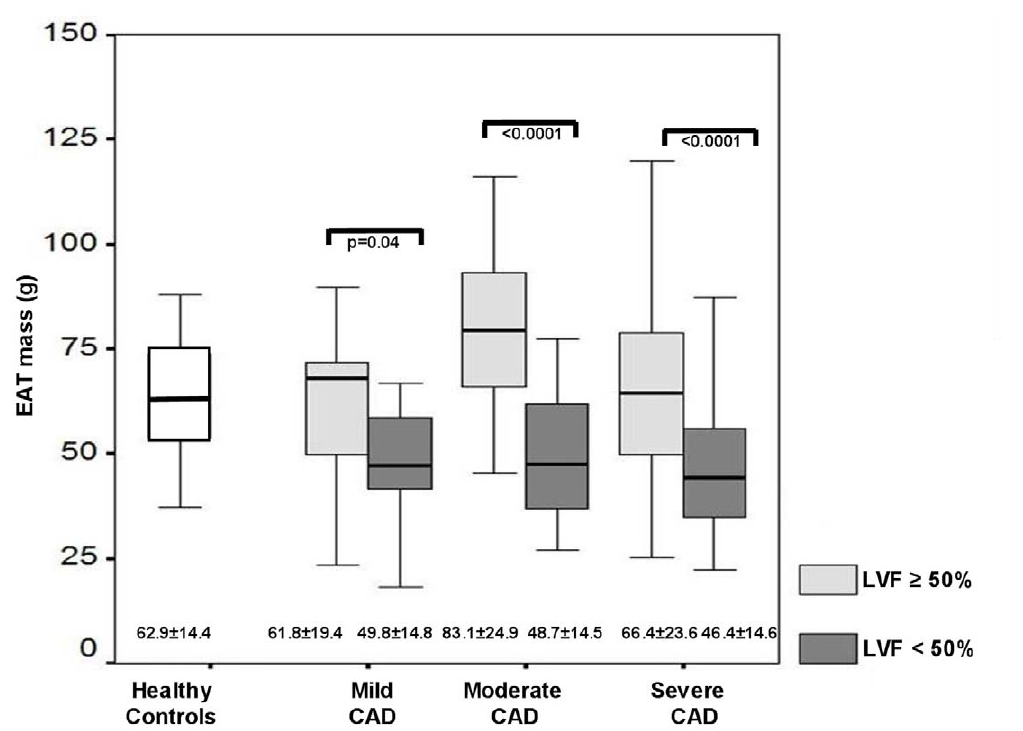
Figure 3. Comparison of EAT mass in patients with the same atherosclerosis severity with regard to LV function. The box plots show the EAT mass in healthy controls (white box plot) and CAD patients. The EAT mass between CAD patients with preserved LVF (LVF $ 50%, light gray box plots) and reduced LVF (LVF , 50%, dark gray box plots) are compared in patients with moderate, mild and severe CAD and the p-values are given. EAT mass is displayed as mean 6 standard deviation below the box plots, the line in the box plots indicates the median value of the data. The figure clearly outlines that patients with preserved LVF (light gray box plots) showed significantly more EAT mass compared to those with reduced LVF (dark gray box plots) regardless of the GSS. Abbreviations: CAD: coronary artery disease, EAT: epicardial adipose tissue, LVF: left ventricular function, GSS: Gensini score.